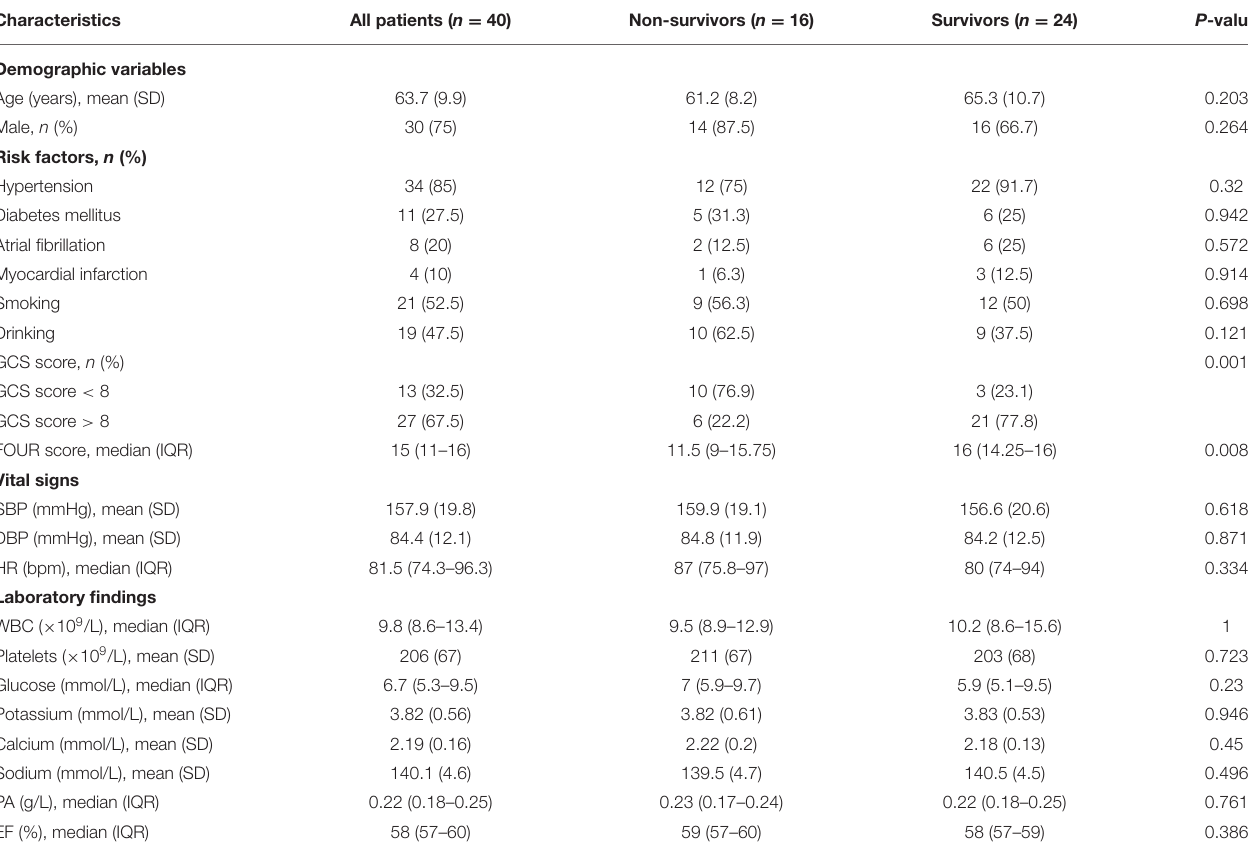
TABLE 1 | Clinical data at